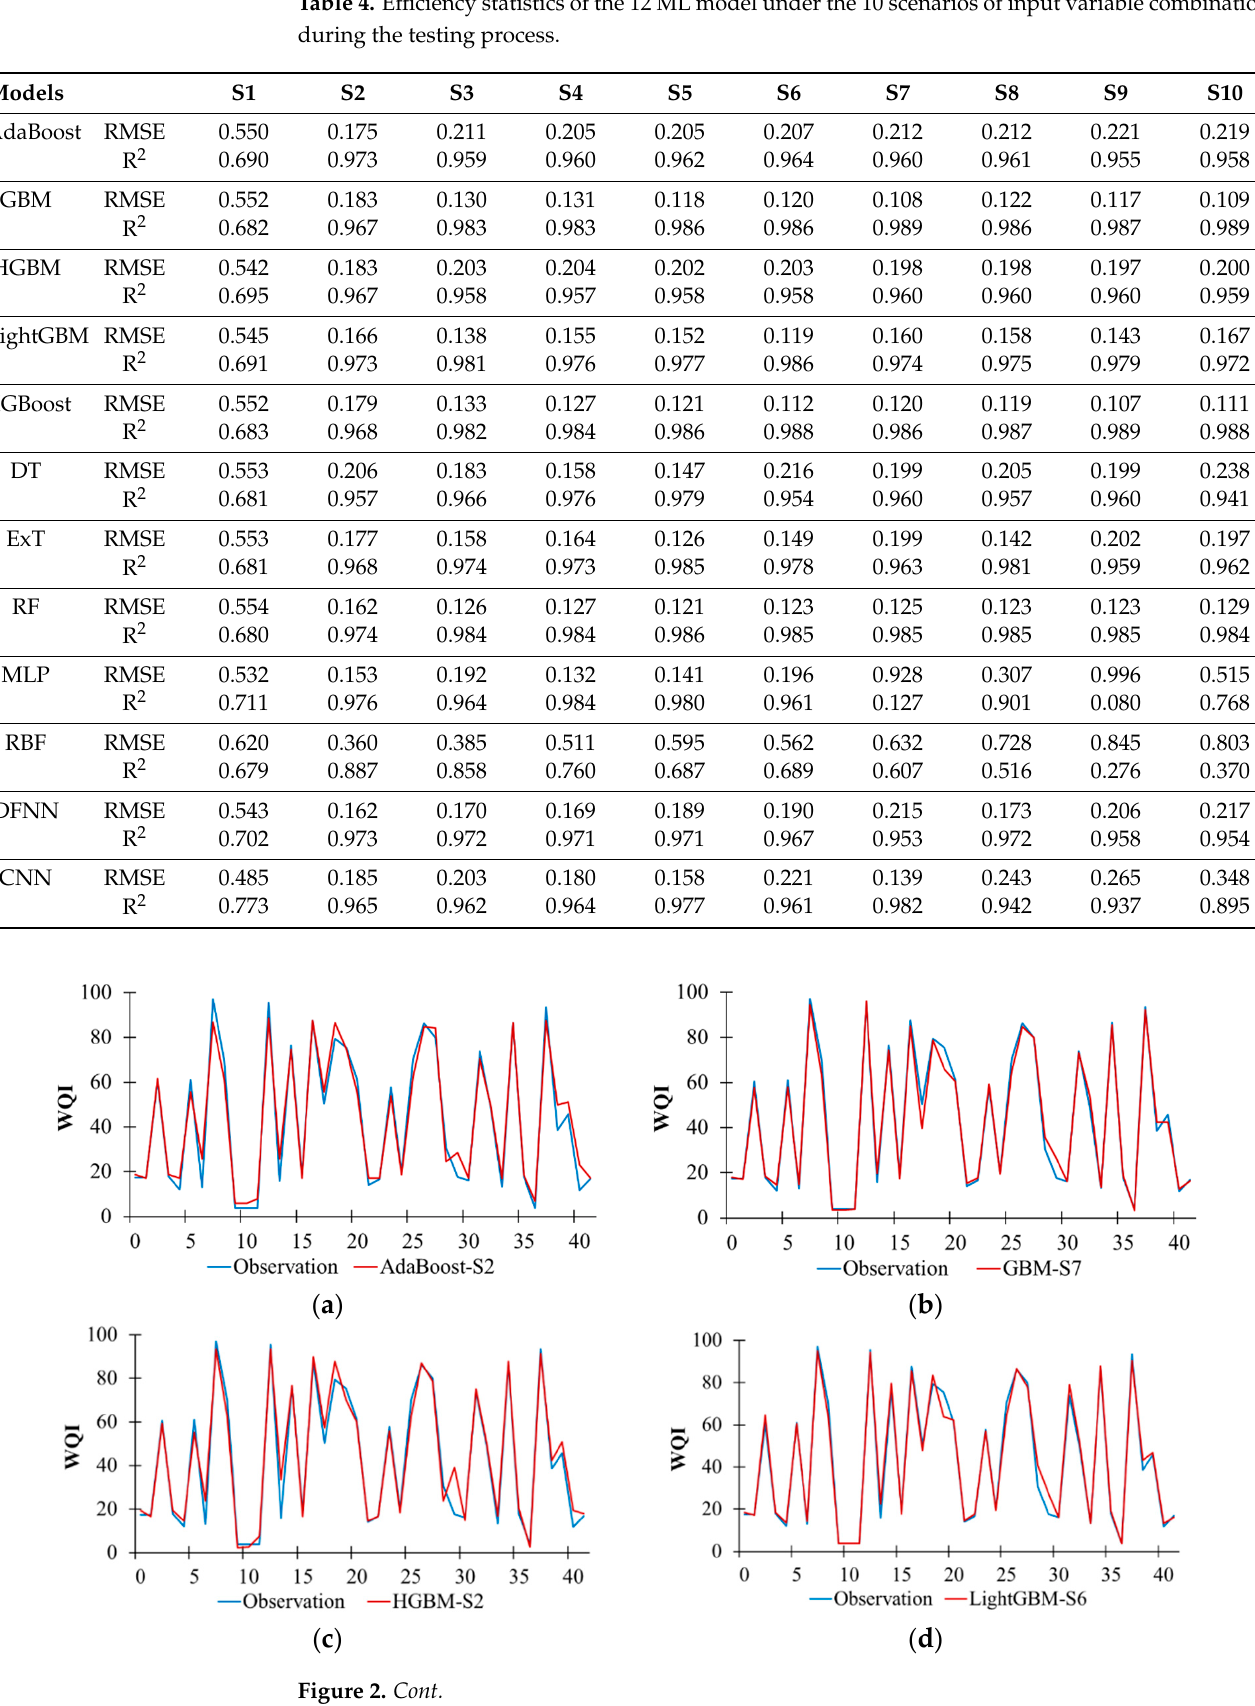
Table 4. Efficiency statistics of the 12 ML model under the 10 scenarios of input variable combina- tions during the testing process.